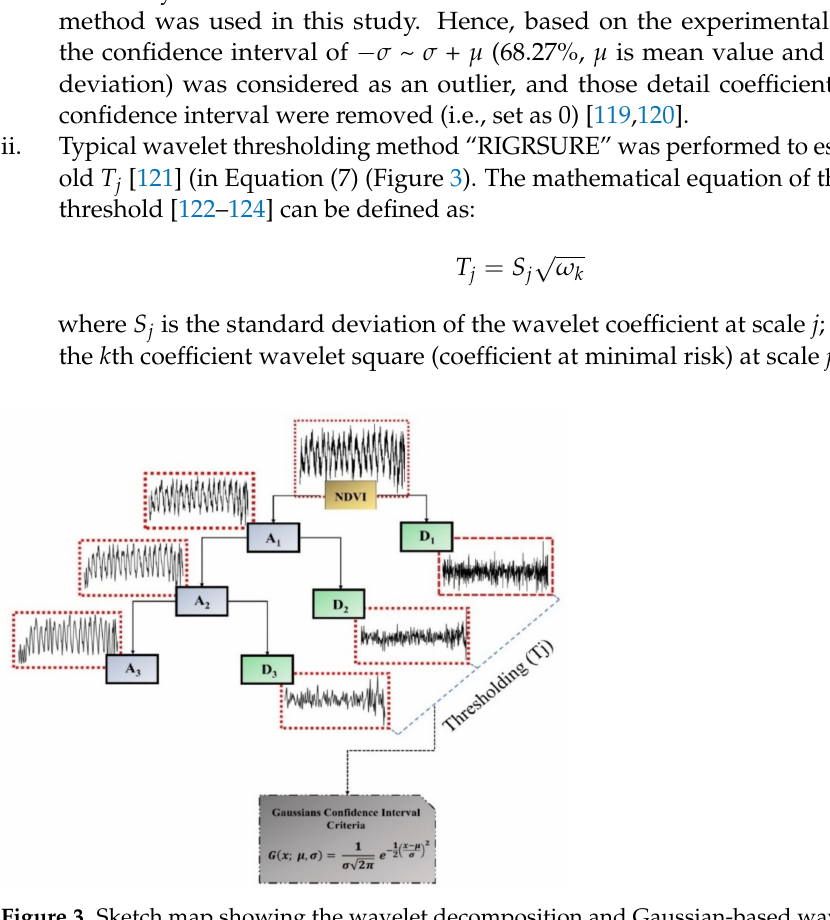
Figure 3. Sketch map showing the wavelet decomposition and Gaussian-based wavelet denoising based on detail coefficient (three decomposition levels are used as an example here). A 1 , A 2 , and A 3 are approximation coefficients from level 1 to level 3. D 1 , D 2 , and D 3 represent details coefficients from level 1 to level 3. x are observations (signal) with mean value µ and standard deviation σ